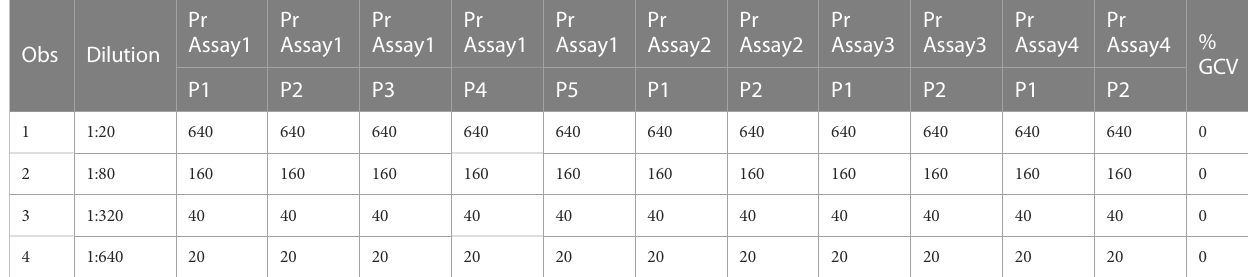
TABLE 3B HAI assay quali fi cation on H3N2 in fl uenza strain A/Texas/71/2017, precision testing, results for intermediate precision.